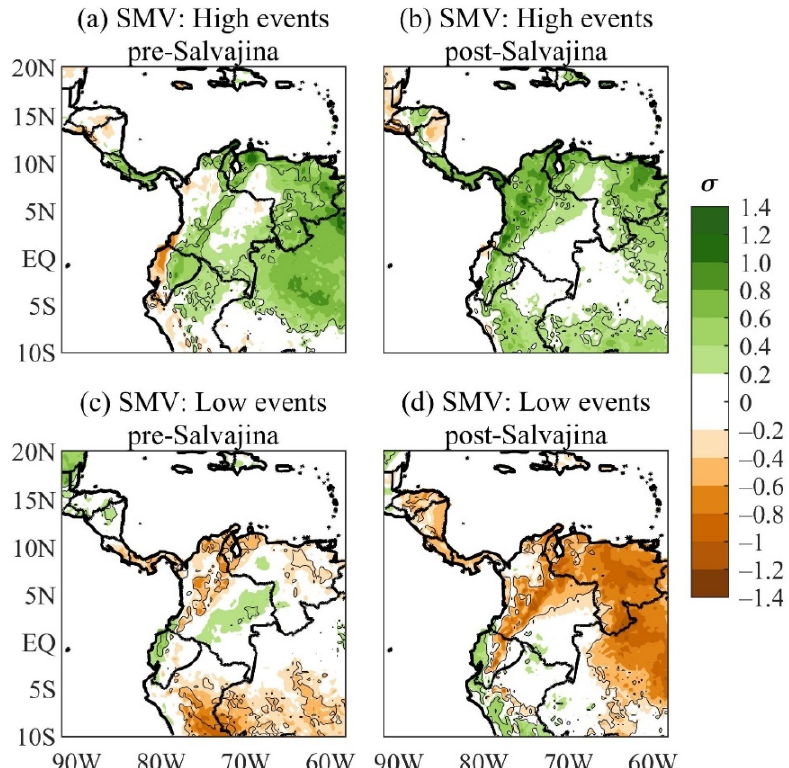
Figure 9. Standardized soil moisture volume (SMV) anomalies during ( a ) high discharge events pre-Salvajina; ( b ) high discharge events post-Salvajina; ( c ) low discharge events pre-Salvajina; and ( d ) low discharge events post-Salvajina. Shading interval: 0.2 SD. Continuous contours indicate significant values at 95% confidence level.